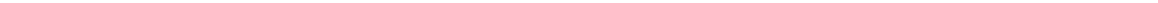
Fig. 6 Activation of H3K27me3 marked genes during stress. a TRAP-seq: Volcano plot showing differential gene expression in mDA neurons from lesioned and unlesioned hemispheres 14 days after unilateral 6-OHDA injections ( n = 5 mice) (Methods). b As in a where H3K27me3 and/or H3K9me3-marked and regulated genes are marked with red. c Gene ontology (GO) of selected ( − log10(adj p -value), Fisher ’ s exact test) biological processes for upregulated genes in mDA neurons of the lesioned hemisphere ( n = 87). d Bars indicate the odds-ratio fold enrichment for upregulated genes after 6-OHDA treatments per chromatin state. Absolute numbers of genes per state are given in parenthesis. Red bars indicate signi fi cant enrichment according to Fisher ’ s exact test and are adjusted for multiple testing. e TRAP-qPCR con fi rming induction of Hrk relative to Tbp in mDA after 6-OHDA. Bars indicate average expression ± SD. Two-tailed Student ’ s t -test assuming equal variances. * p ≤ 0.05. f Genome browser excerpt showing H3K4me3 (K4, red, vertical scale 0 – 160 RPKM) and H3K27me3 (K27, gray, vertical scale 0 – 100 RPKM) enrichment at the Hrk locus in naive mDA nuclei. g ChIP-qPCR in mDA nuclei showing fold-enrichment of IgG, K4, and K27 relative to input near the Hrk TSS. Bars indicate average enrichment ± SD. K4 enrichment was signi fi cantly higher near Hrk compared to near the Hoxa2 TSS and K27 enrichment was signi fi cantly higher compared to near the Tbp TSS (Supplementary Fig. 11f,h). Two-tailed Student ’ s t -test assuming equal variances. *** p ≤ 0.001. h – j As in e – g for Penk . k TRAP-seq: Volcano plot showing differential gene expression in mDA neurons 2 h after a single methamphetamine injection compared to saline-injected controls, similar to a . l As in k where H3K27me3 and/or H3K9me3-marked and regulated genes are marked with red. m GO for selected ( − log10 (adj p -value), Fisher ’ s exact test) biological processes for upregulated genes in mDA neurons after methamphetamine ( n = 52). n Odds ratio for upregulated genes after methamphetamine per chromatin state as in d . o – t Examples of upregulated K4/K27 genes after methamphetamine, similar to e – g . u Silent genes with K4/K27-marked promoters are commonly involved in stress responses: GO for selected ( − log10 (adj p -value), Fisher ’ s exact test) biological processes for K4/K27 genes with log2(RPKM + 1)<1